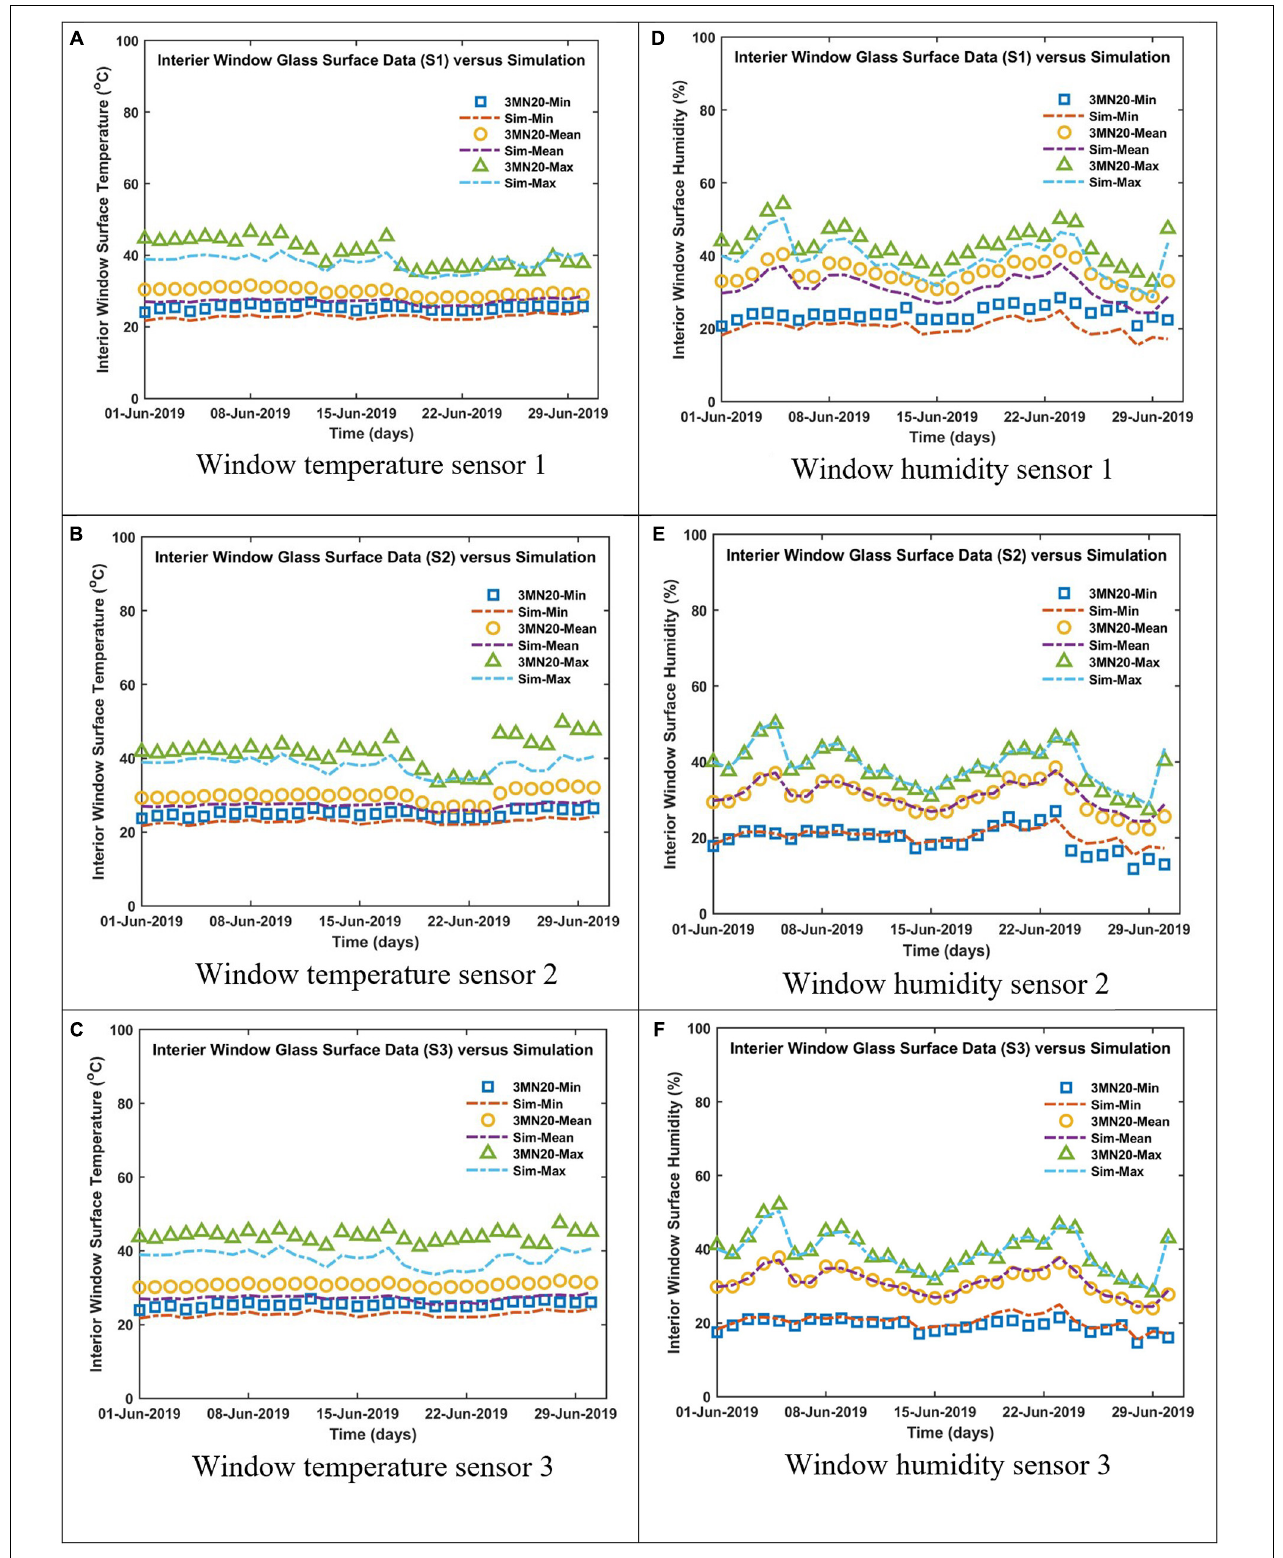
FIGURE 16 | Temperature and humidity (max-mean-min) for three DHT22 sensors on the interior glass surface data versus simulations (Sim) of the offices with 3M Neutral 20 (3MN20) windows during the month of June 2019; (A–C) temperatures, and (D–F) humidity variations.